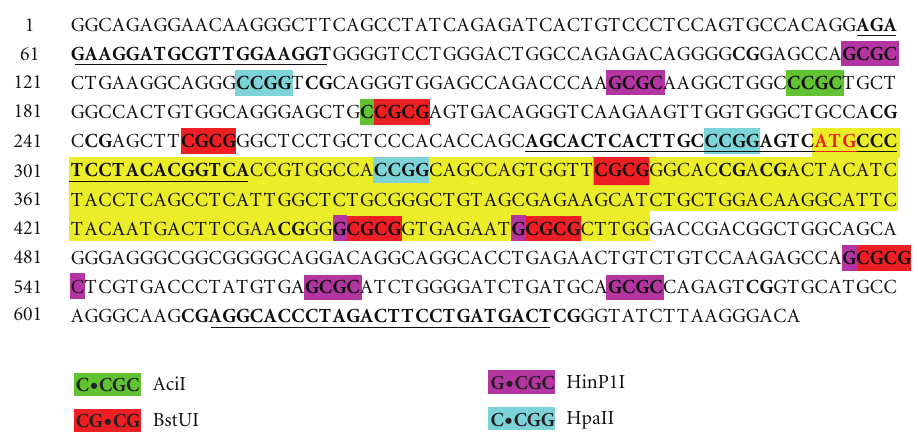
Figure 1: The sequence of the mouse 5-LOX promoter-5 (cid:2) UTR and the first exon-intron region subjected to the methylation-sensitive endonuclease assay with the four endonucleases—AciI, BstUI, HinP1I, and HpaII. The yellow highlight indicates the first exon including the start codon (ATG, in red). The four endonuclease-targeted methylation-sensitive endonuclease recognition sites are highlighted by four di ff erent colors. The selected DNA sequence included 2 AciI-sensitive sites (upstream of the start codon), 6 BstUI-sensitive sites (2 upstream and 4 downstream of the start codon), 8 HinP1I-sensitive sites (2 upstream and 6 downstream of the start codon), and 3 HpaII-sensitive sites (2 upstream and 1 downstream of the start codon). The primer regions used for quantitative PCR amplification are underlined; primers were used as follows. Promoter - 5 (cid:2) UTR: forward = 5 (cid:2) -aga gaa gga tgc gtt gga aggt-3 (cid:2) and reverse = 5 (cid:2) -gac tcc ggg caa gtg agt gct-3 (cid:2) ;